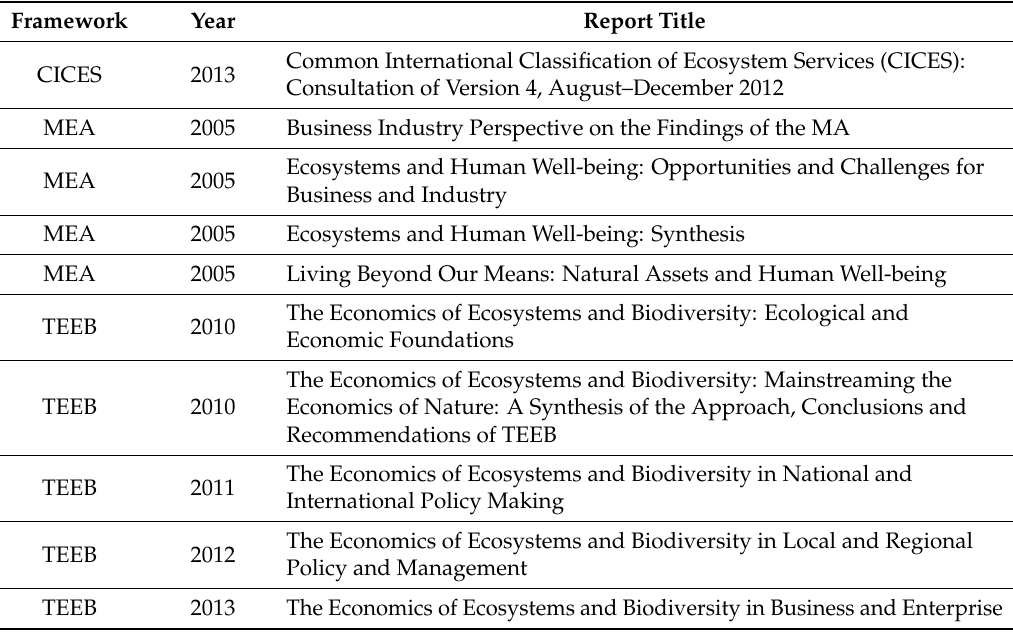
Table 1. Selected reports for discourse analysis on the concept of